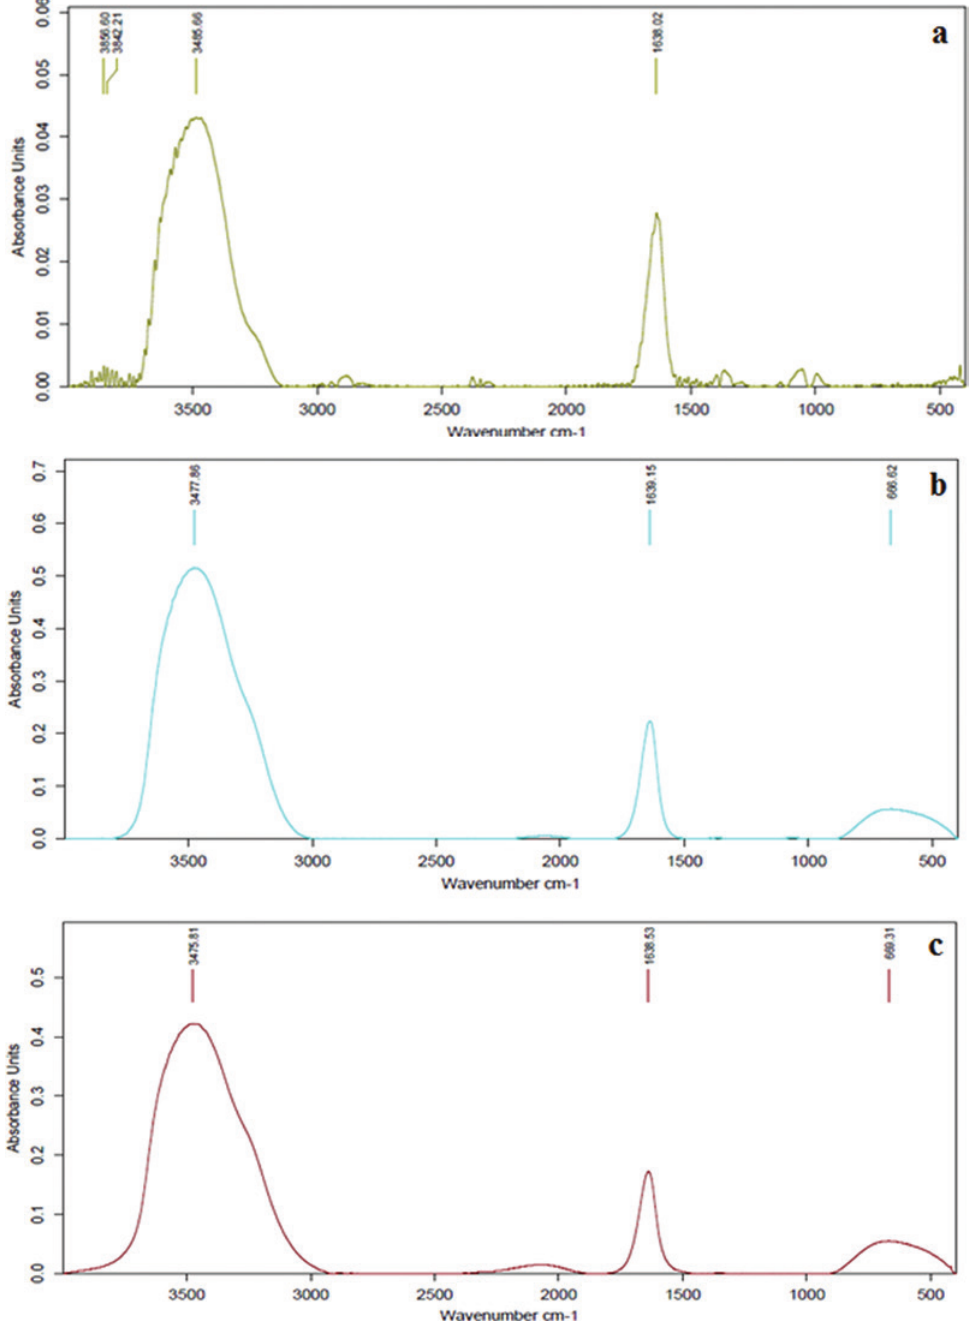
Figure 2: Fourier transform infrared (FT-IR) spectrums of the extracted saponin using (A) microwave, (B) autoclave and (C) Bain-Marie heating